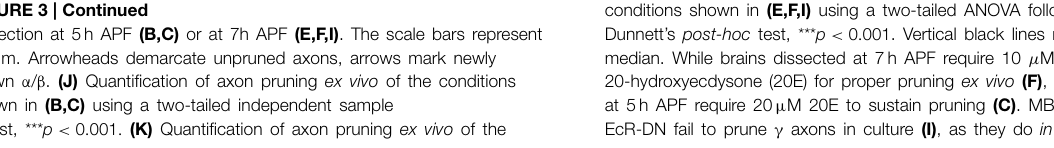
last time point— C–E 4 ). Axons projecting to the dorsal and medial γ lobes were eliminated during the culturing of WT MBs (arrows in C 4 , D 4 ), while the cell bodies and the proximal part of the axons remain intact (arrowheads in C 4 , D 4 ). In brains expressing EcR-DN axon elimination was inhibited and the axons remain intact throughout the imaging (arrows in E 4 ). D, Dorsal lobe; M, medial lobe. See also Supplemental Movies